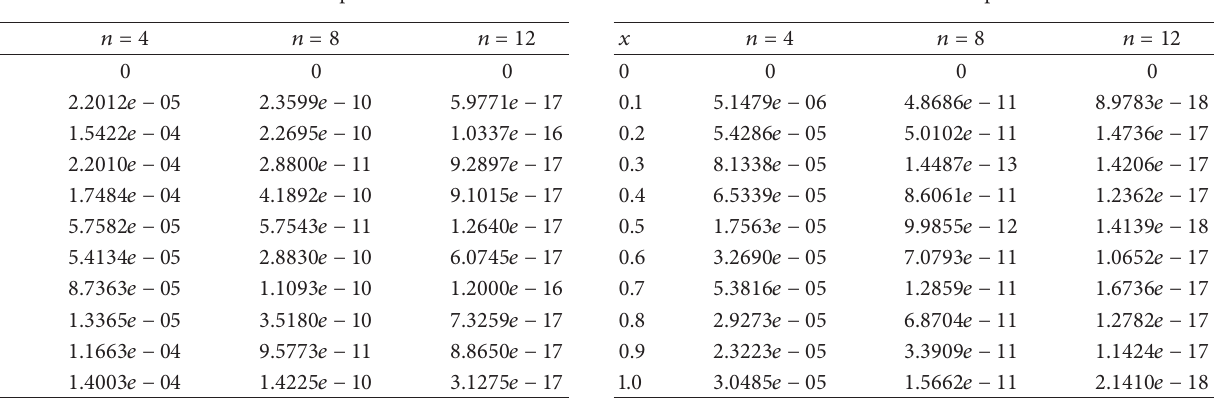
Table 2: Absolute errors for Example 2 at different 𝑛 . Table 3: Absolute errors for Example 3 at different 𝑛 .